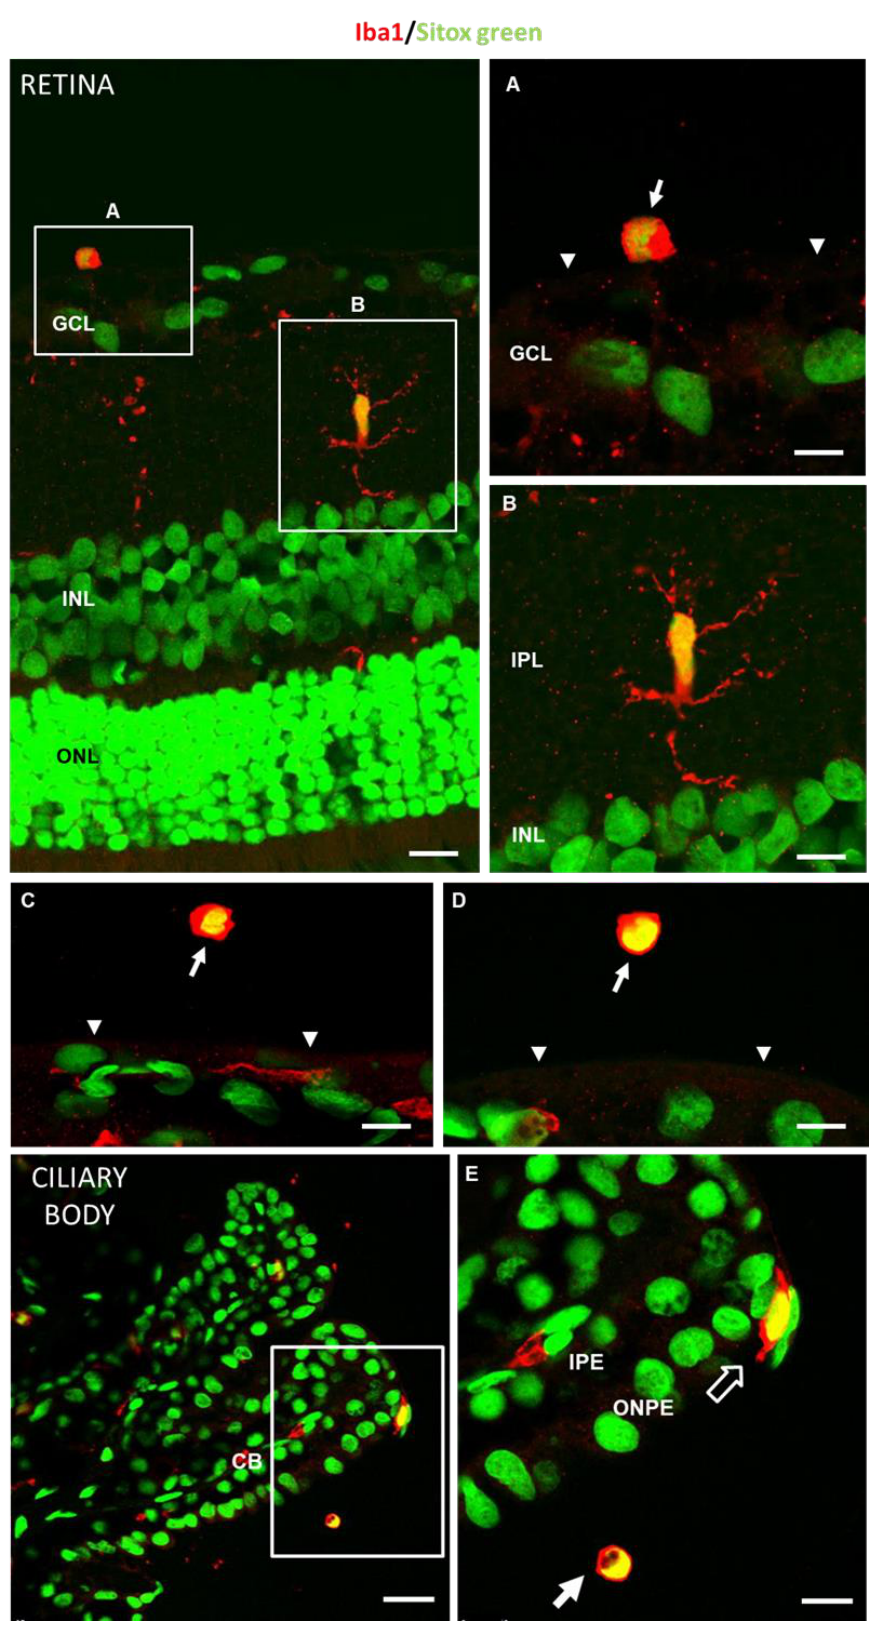
Figure 6. Hyalocyte-like cells in hypertensive rat eyes showed positive for Iba1 (arrows). ( A , C , D , E ): Examples of Iba1 positive hyalocyte-like cells. ( B ): Activated microglia embedded in the retina also showed, as expected, positive for Iba1. ( E ): The presence of Iba1 positive cells crossing the